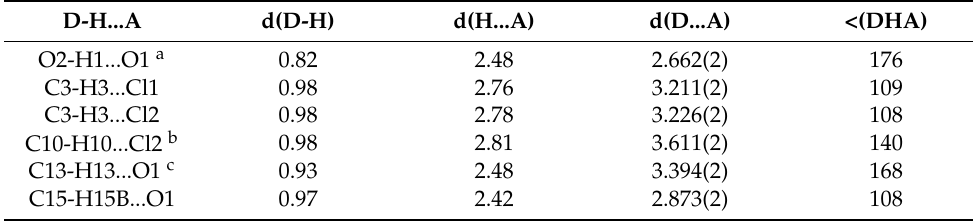
Figure 4. Fingerprint plots for all interactions in 5. Figure 5. Percentages and intermolecular interaction summary for 5 .